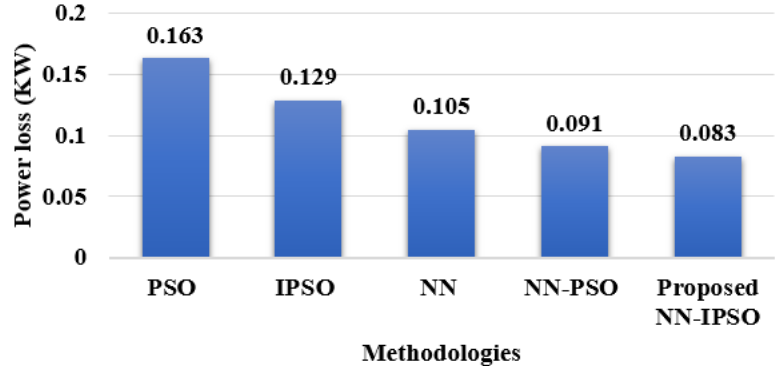
Figure 9. Zoom view of efficiency.